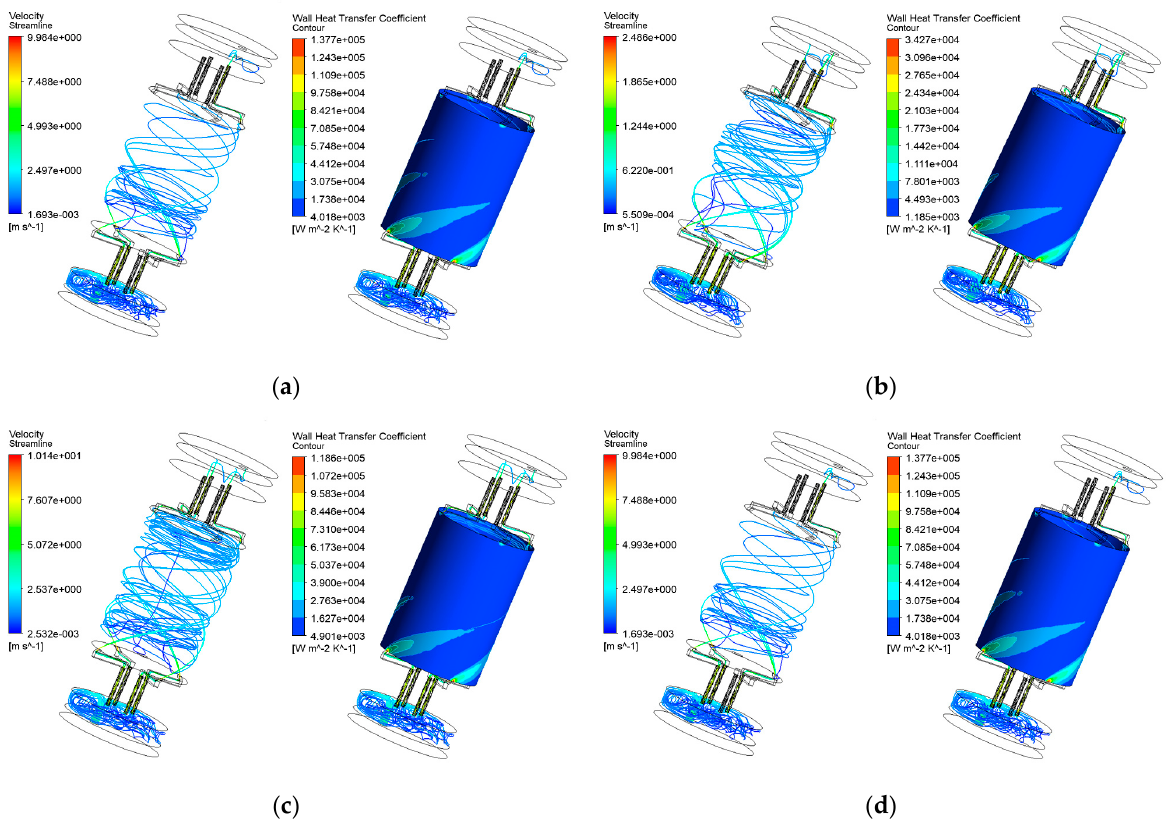
Figure 7. Simulation in CFX under different surface roughness and velocities: ( a ) R30-1 m/s; ( b ) R100-1 m/s; ( c ) R30-4 m/s; ( d ) R100-4 m/s. Table 6. The average calculated convective heat transfer coefficient of the cavity under different structural optimizations and inlet water velocities.